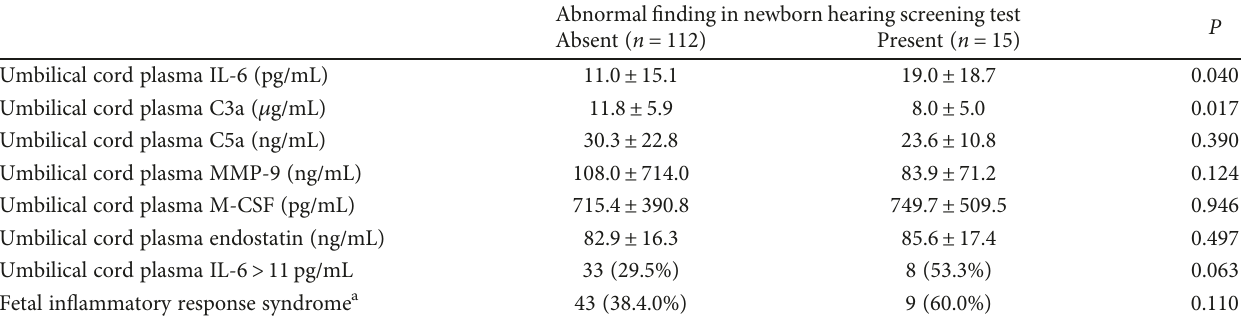
Table 2: Umbilical cord plasma levels of in fl ammatory and immune proteins according to newborn hearing screening test results. Abnormal fi nding in newborn hearing screening test P Absent ( n = 112 ) Present ( n = 15